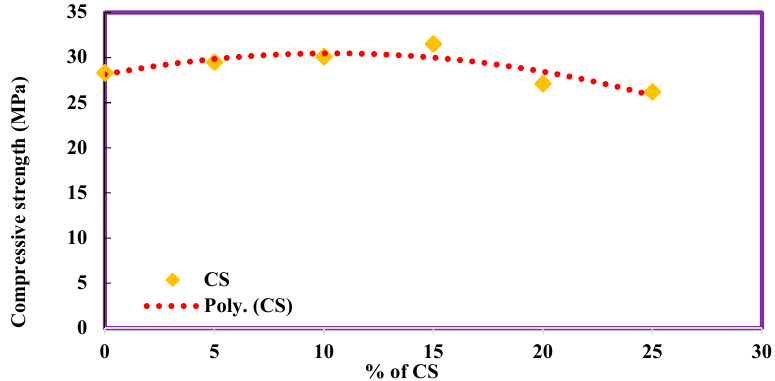
Figure 4. Compressive strength of CS concrete.